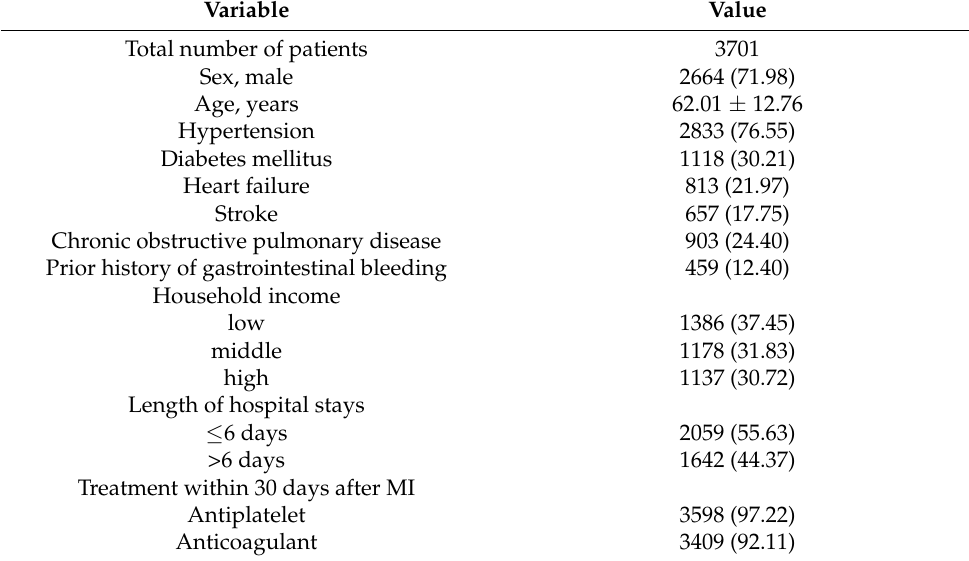
Table 1. Baseline characteristics of included